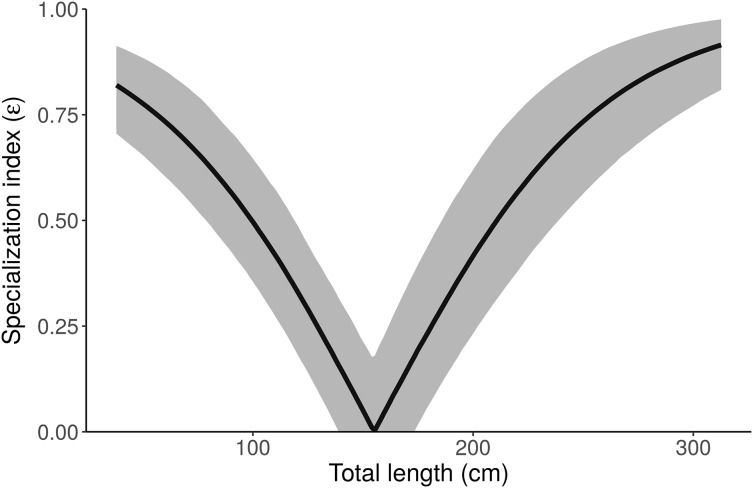
Posterior distribution of the specialization index (ε) as a function of length from the “Length” model.Small and large alligators are highly specialized (on freshwater and marine prey, respectively), whereas average-length alligators have low specialization index (i.e., are consuming both freshwater and marine prey). Specialization index is calculated using Eq. 5 in Newsome et al. (2012) from individual MCMC draws of pfreshwater and pmarine as a function of length. The line depicts the posterior median and shading displays the 95% credible interval.